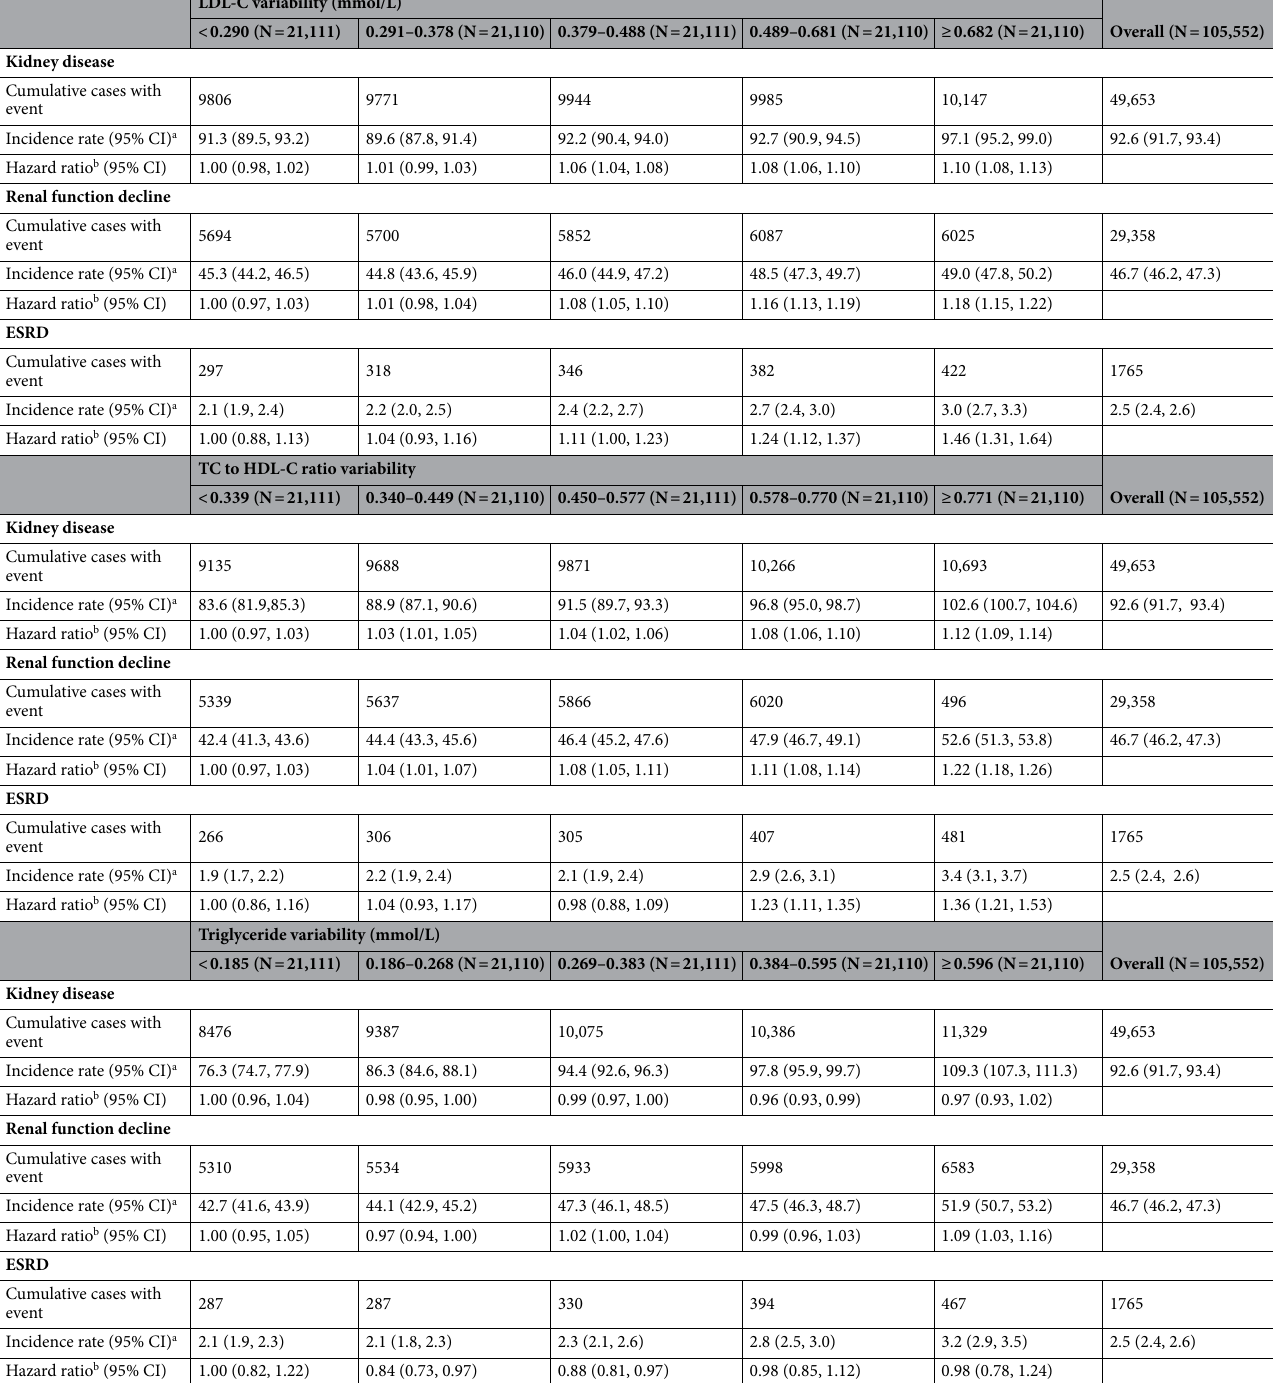
Table 2. Number, incidence rate and hazard ratio of kidney disease, renal function decline, and ESRD, stratified by LDL-C, TC to HDL-C ratio and triglyceride variability. ESRD End stage renal disease,